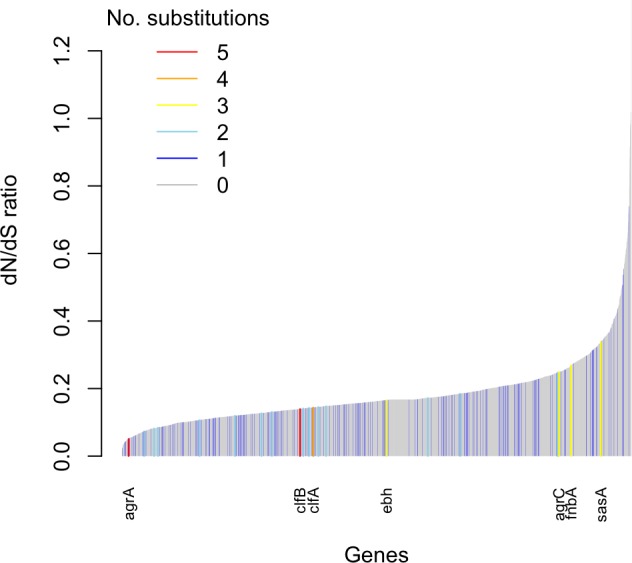
Genes enriched for substitutions between nose-colonizing and infection-causing bacteria within patients are not the most rapidly evolving at the species level.An estimate of the dN/dS ratio between unrelated bacteria is shown for each gene, color-coded by the number of protein-altering substitutions between nose-colonizing and infection-causing bacteria within patients. There was a negative Spearman rank correlation between dN/dS ratio and substitutions within patients (ρ = –0.04, p=0.02).